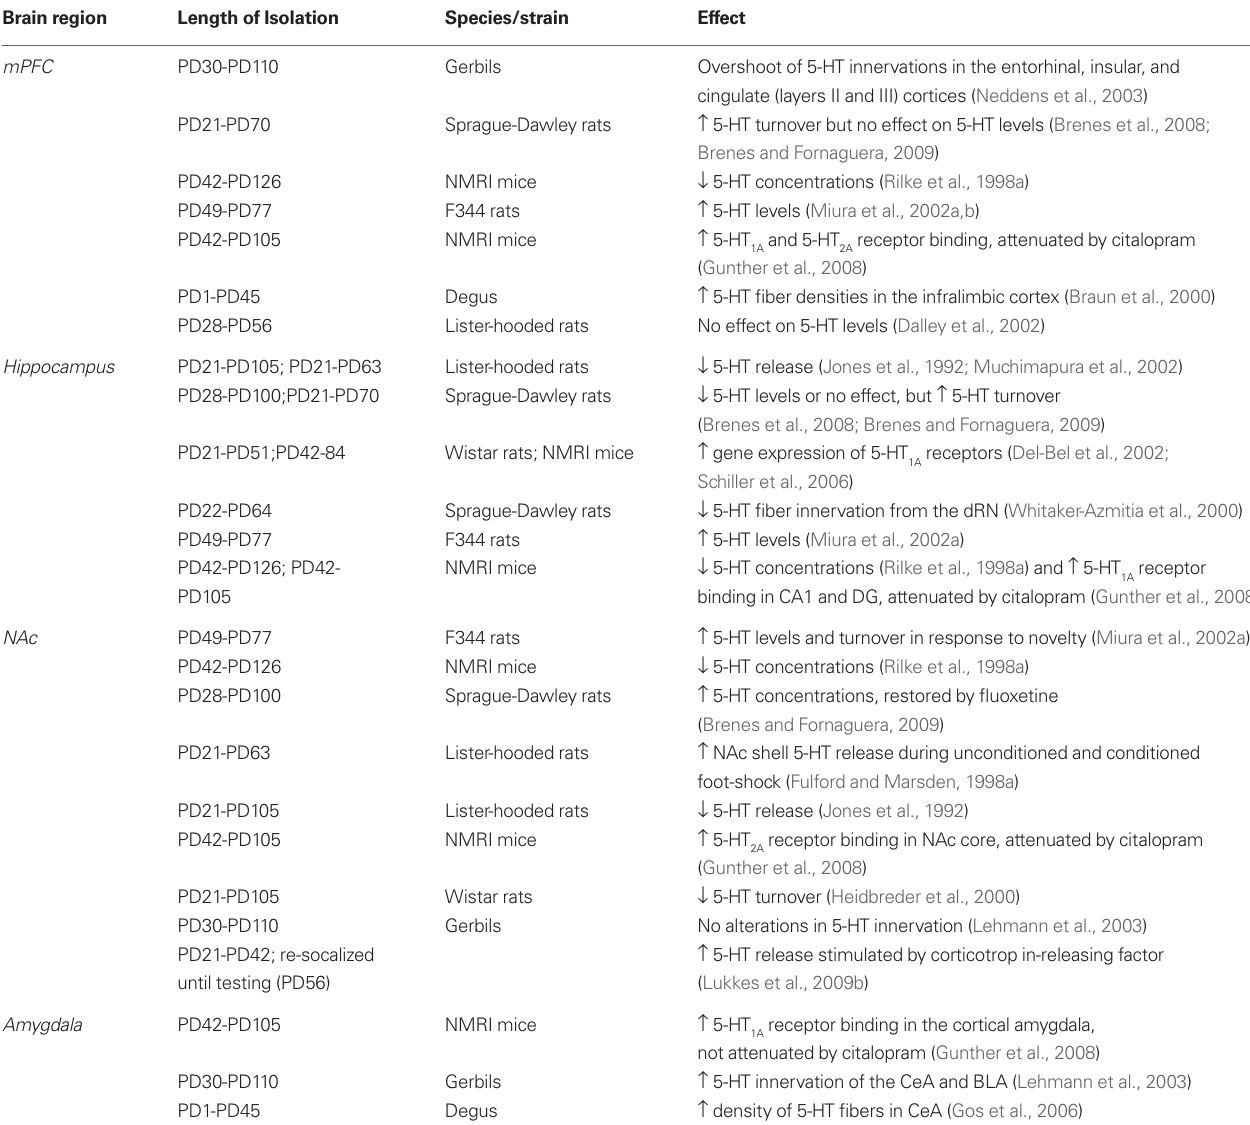
Table 1 | Effects of isolation rearing on serotonergic function within anxiety-related neural circuits. Brain